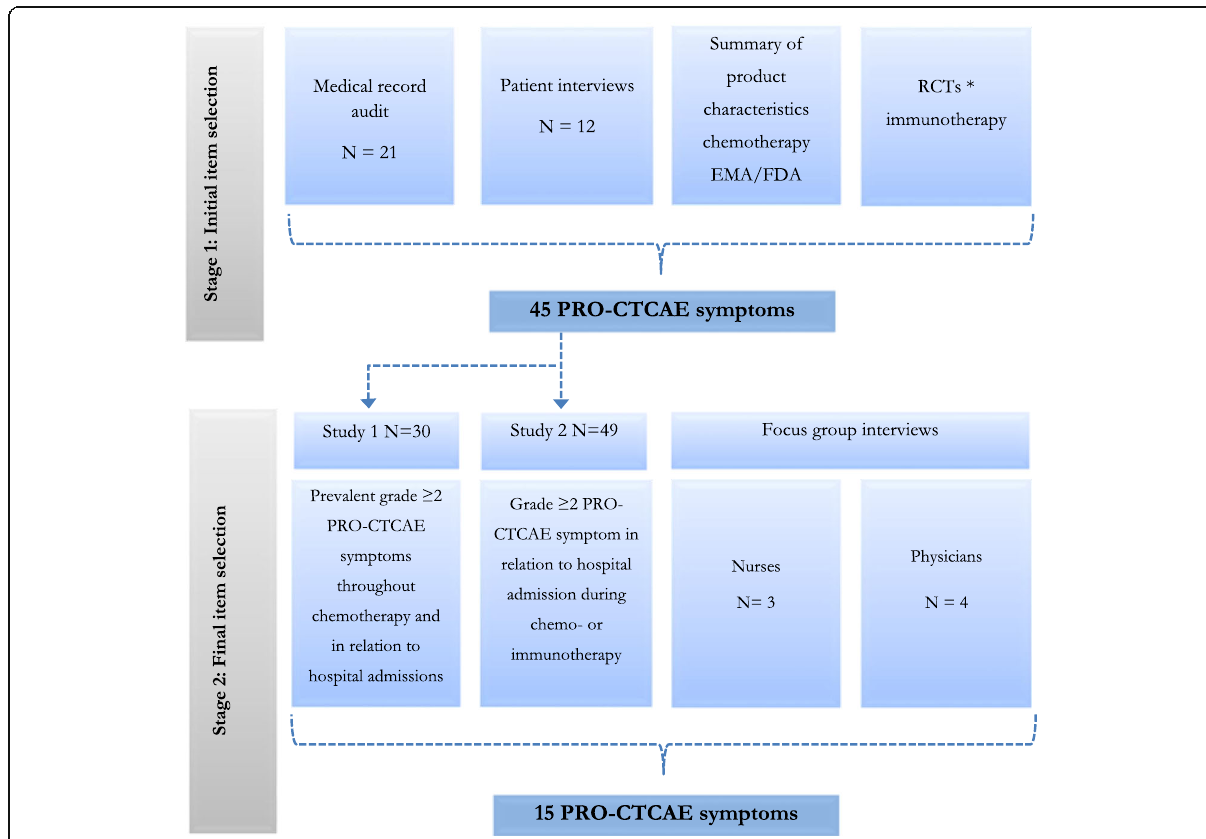
Fig. 1 Item Selection Process. legend: *Rosenberg et al., Lancet 2016, Bellmunt et al., NEJM,